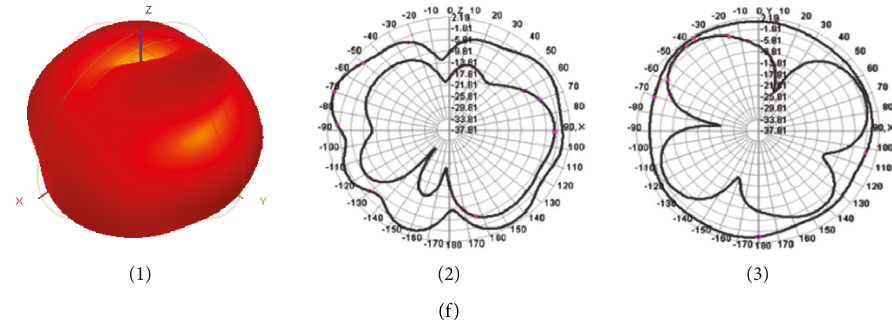
Figure 13: (1) 3D far-field radiation pattern of the antenna, (2) E-plane co-pol and cross-polarization comparison diagram, and (3) H-plane co-pol and cross-polarization comparison diagram; (a) 2.35GHz, (b) 2.55GHz, (c) 2.85GHz, (d) 3.65GHz, (e) 5.6GHz, and (f) 6.3 GHz.